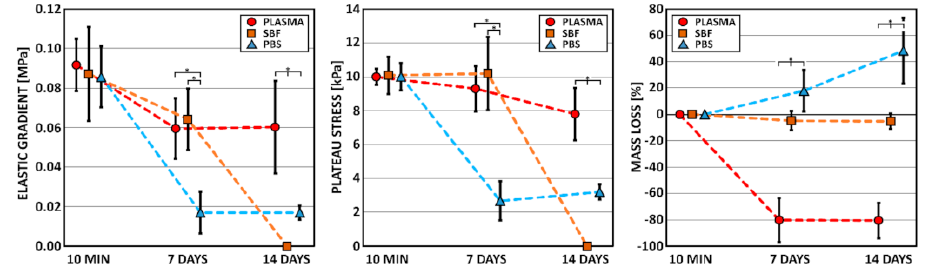
Figure 1. Elastic gradient (elastic modulus), plateau stress (compressive strength), and mass loss of the collagen scaffolds immersed in human blood plasma, SBF, and PBS for 10 min, 7 days, and 14 days (arithmetical mean with standard deviation, n = 10). * denotes statistically significant differences (Games–Howell, 0.05